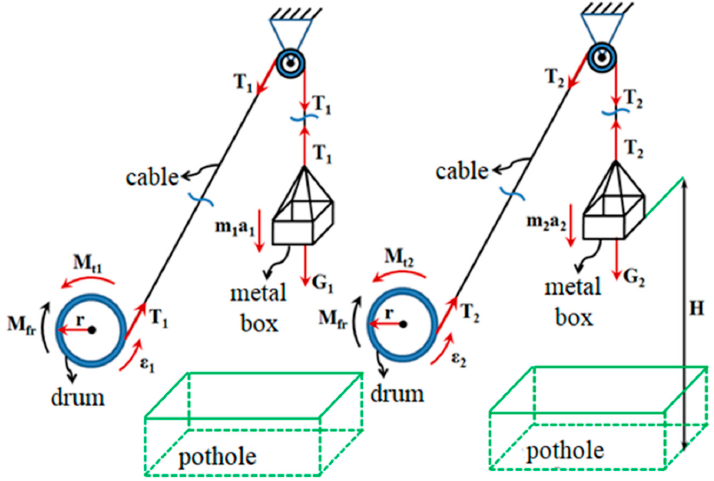
Figure 17. The classical gravitational method, the representation of forces and moments.